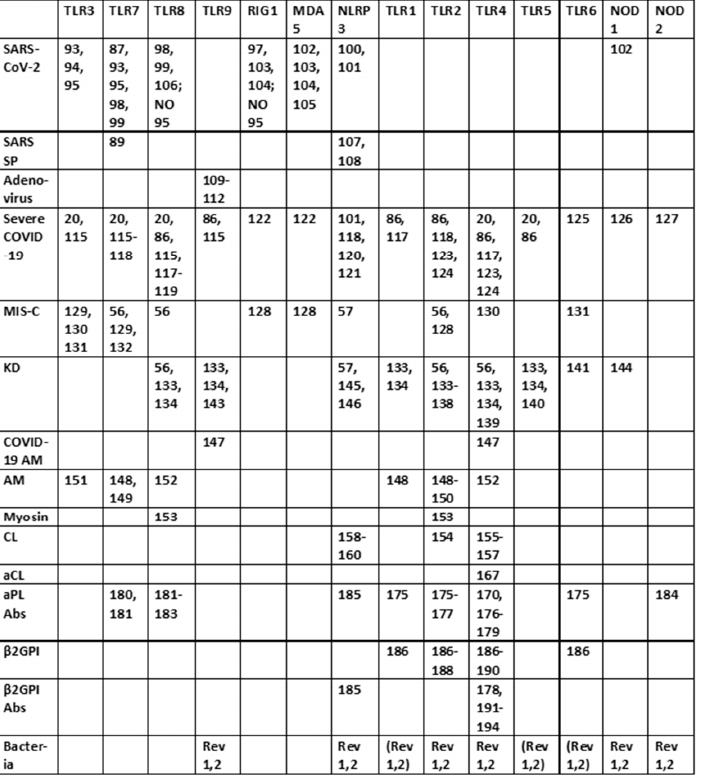
Figure 3. Summary of results. Each number refers to an article cited in the References. Rev = “reviewed in”; (Rev 1,2) indicates that these TLR activations only occur for some bacteria. Full references to